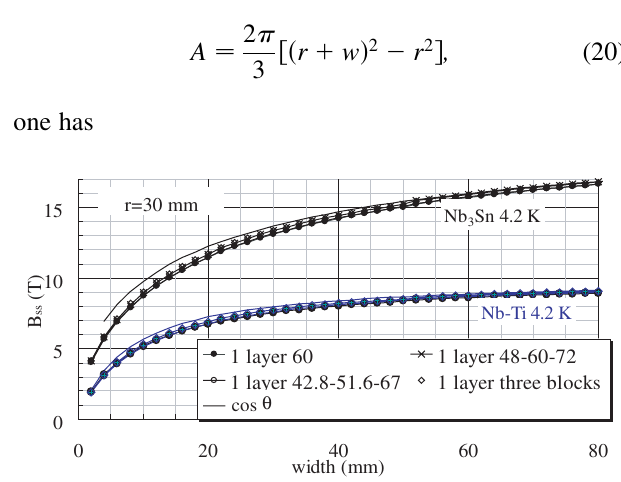
FIG. 5. Numerical evaluation of (cid:7) and fit defined in Eq. (18) versus sector width for different sector layouts, aperture radius of 30 mm.